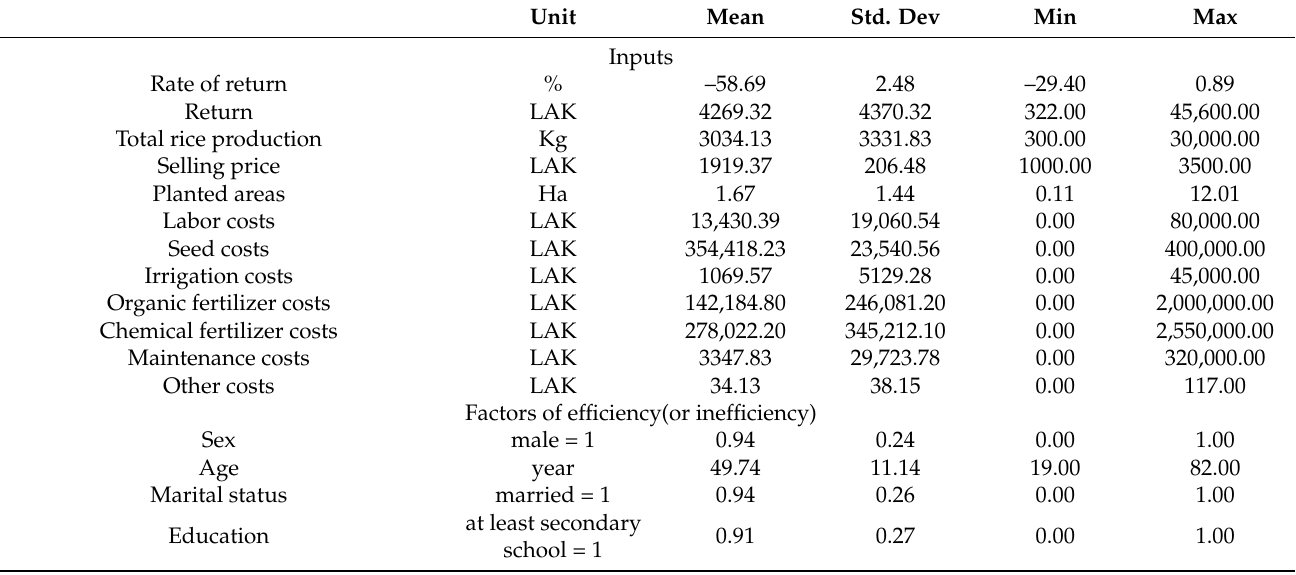
Table 1. Summary